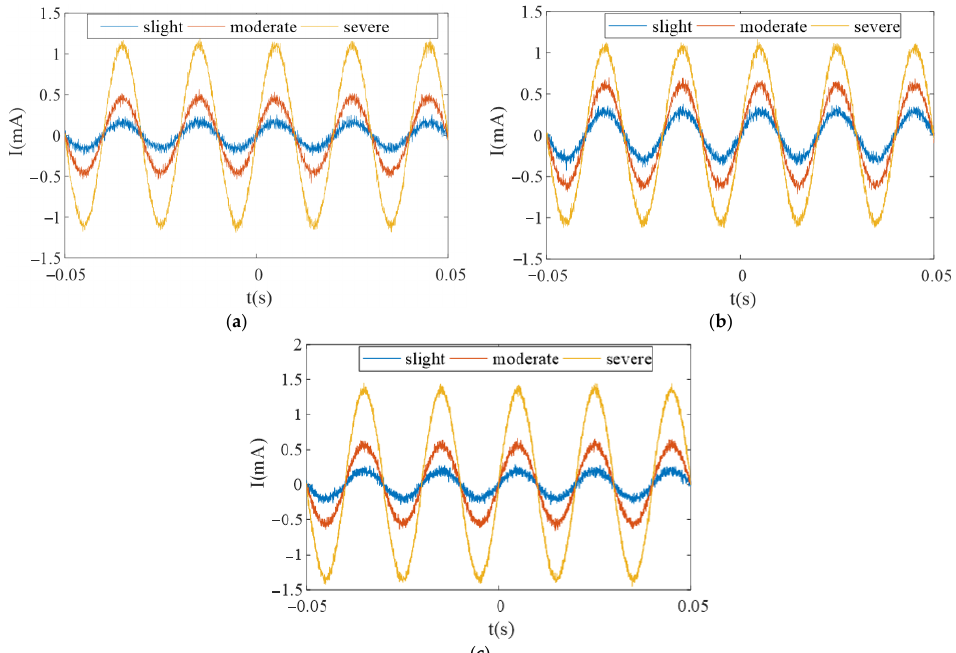
Figure 20. The change of leakage current in the different moisture states of each sample. ( a ) sample 1; ( b ) sample 2; ( c ) sample 3. ( b ) sample 2; ( c ) sample